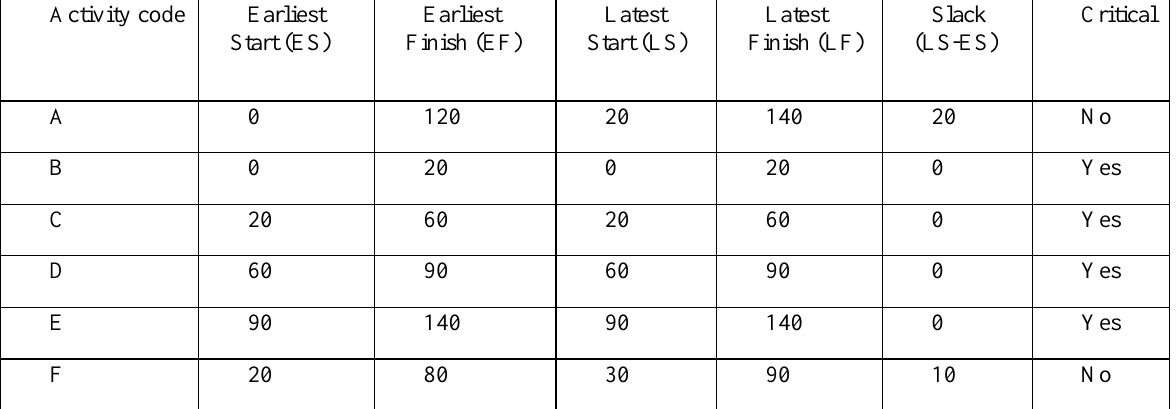
Table 3. Computation of critical path method.